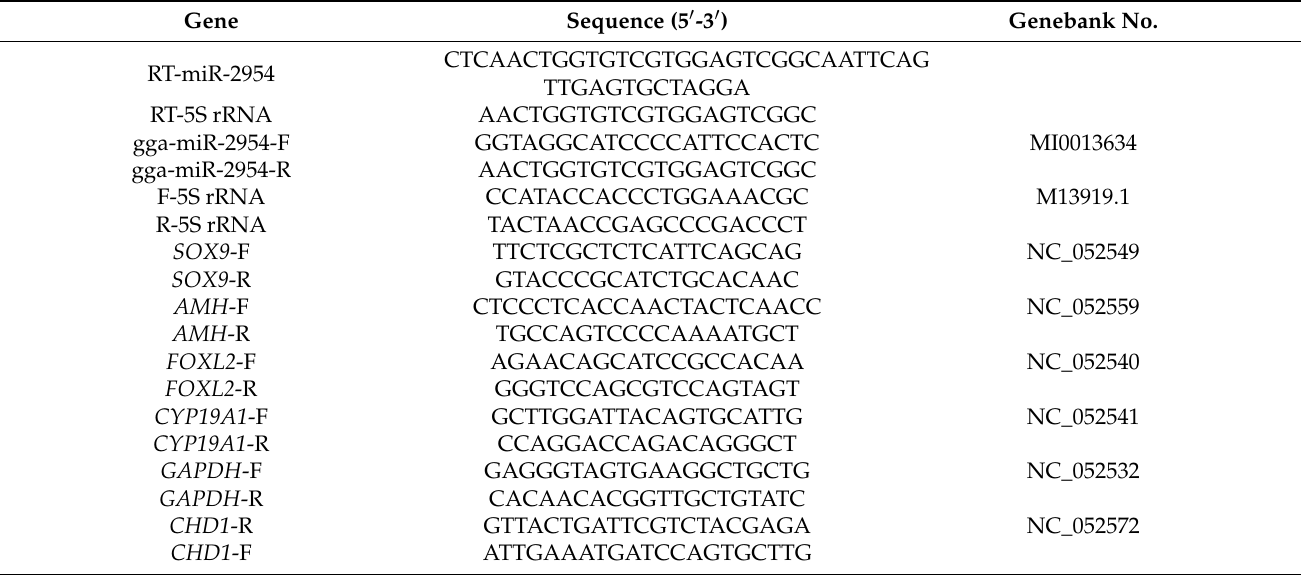
Table 1. Primers used in reverse transcription and